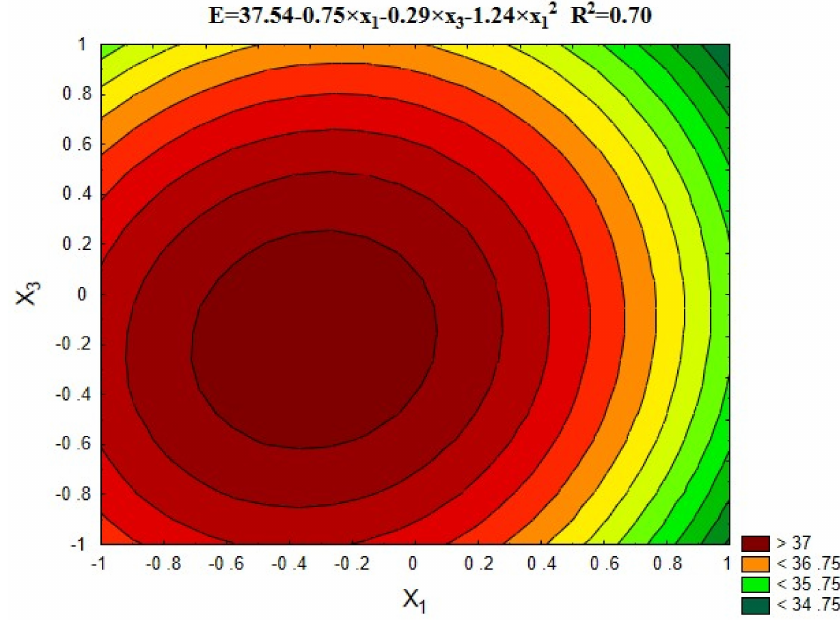
Figure 7. The changes in Young’s Modulus depending on x 1 and x 3 (x 2 =